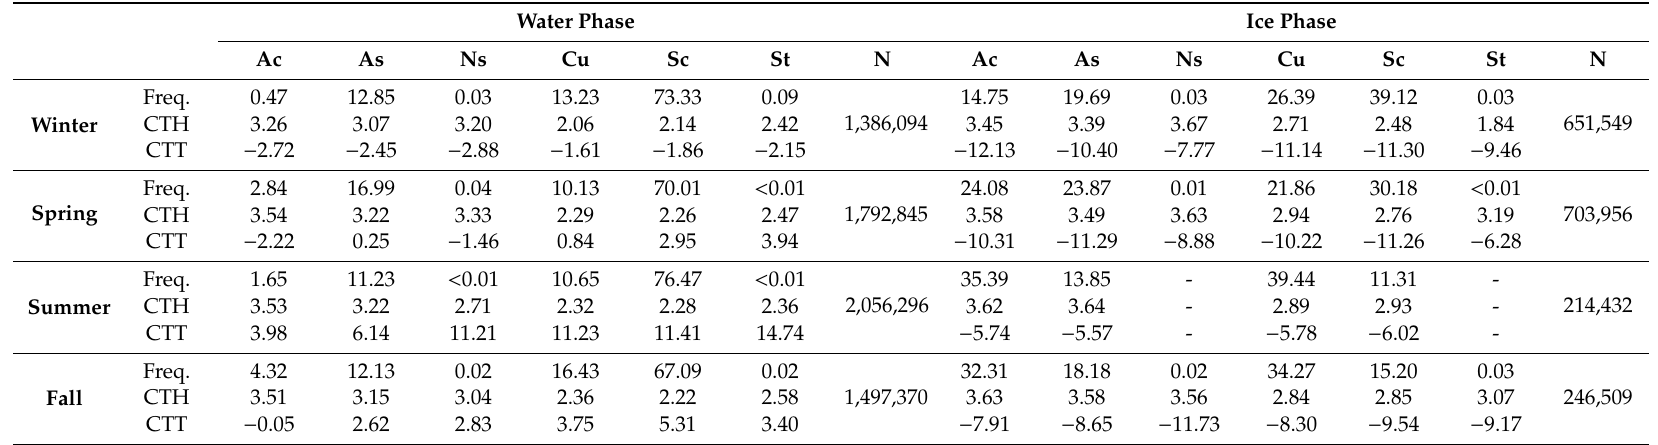
Table 2. Average seedable cloud occurrence frequency, cloud top height (CTH), cloud top temperature (CTT) by season, seedable water phase cloud type, and ice phase clouds. Freq. denotes the occurrence frequency (%). CTH is in km, CTT is in ◦ C, and N is seasonal seedable cloud frequency according to cloud phase. < 0.01 indicates a frequency less than 0.01%. There was no data with minus signs ( −